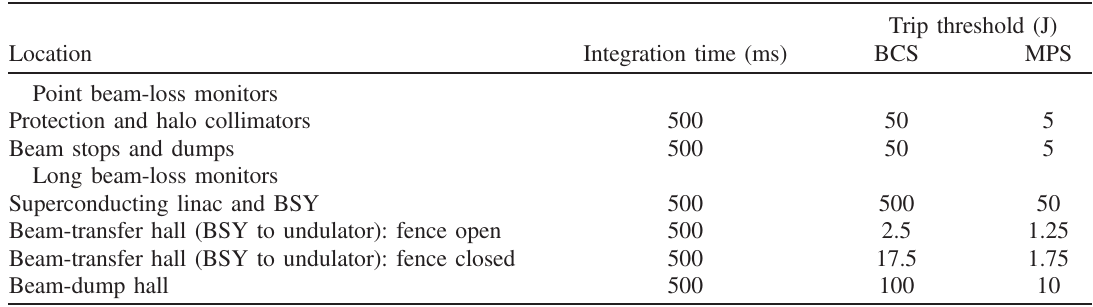
TABLE II. Thresholds and times for the BCS and MPS faults at various locations in